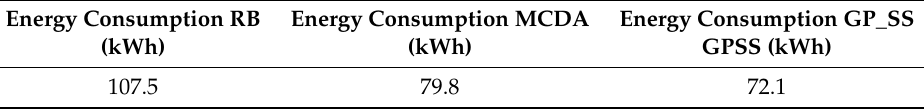
Table 2. Energy consumption of VRF5 under the different control